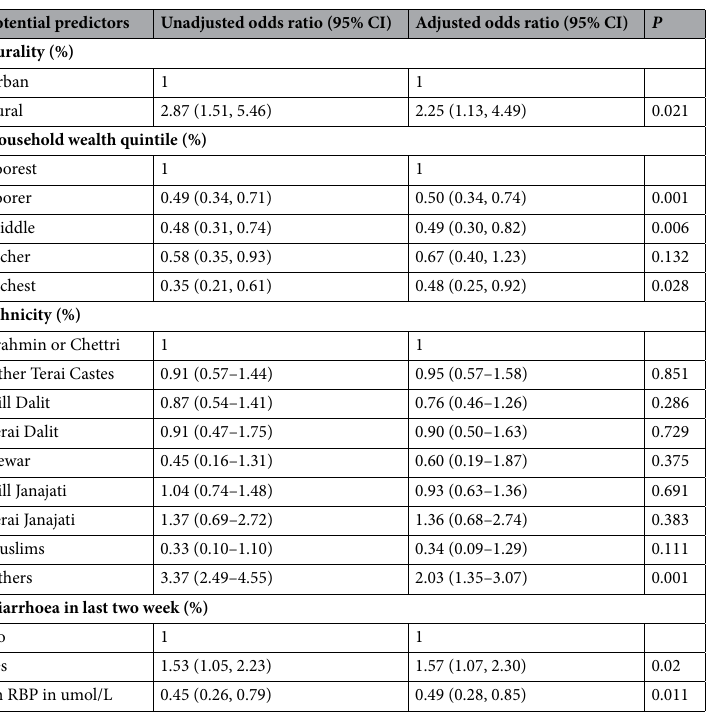
Table 2. Predictors of zinc deficiency among children aged 6 to 59 months, Nepal National Micronutrient Status Survey, Nepal, 2016. Estimates are unadjusted odds ratios and adjusted odds ratios with 95% confidence intervals from logistic regression models, accounting for weighting and complex sampling